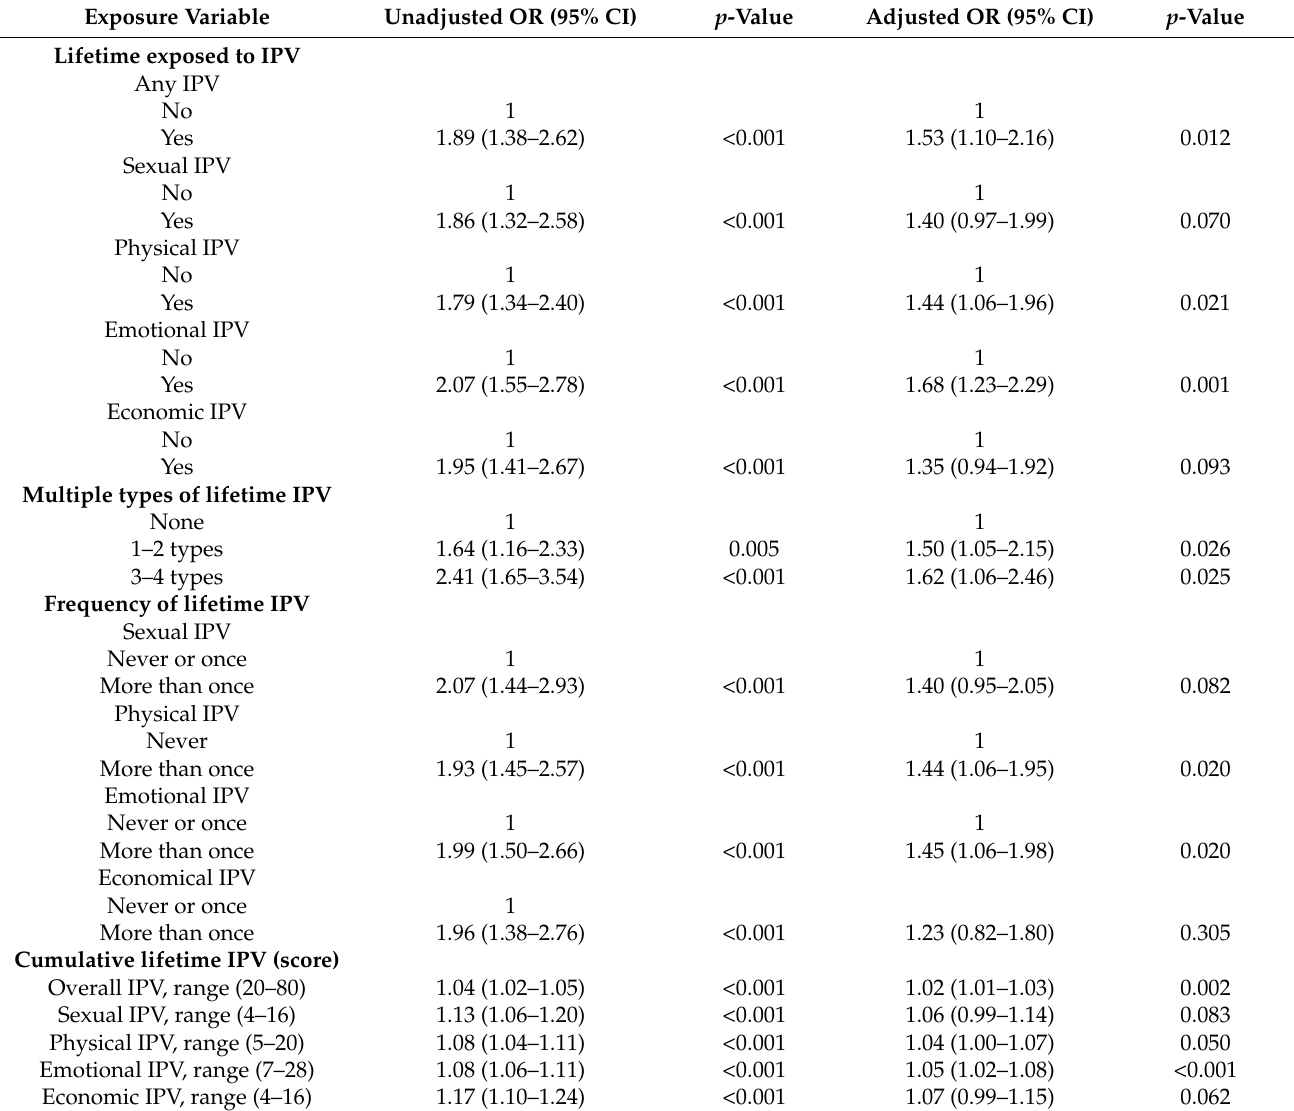
Table 3. Logistic regression analyses (odds ratios, 95% confidence intervals) for the associations of lifetime exposure to intimate partner violence with